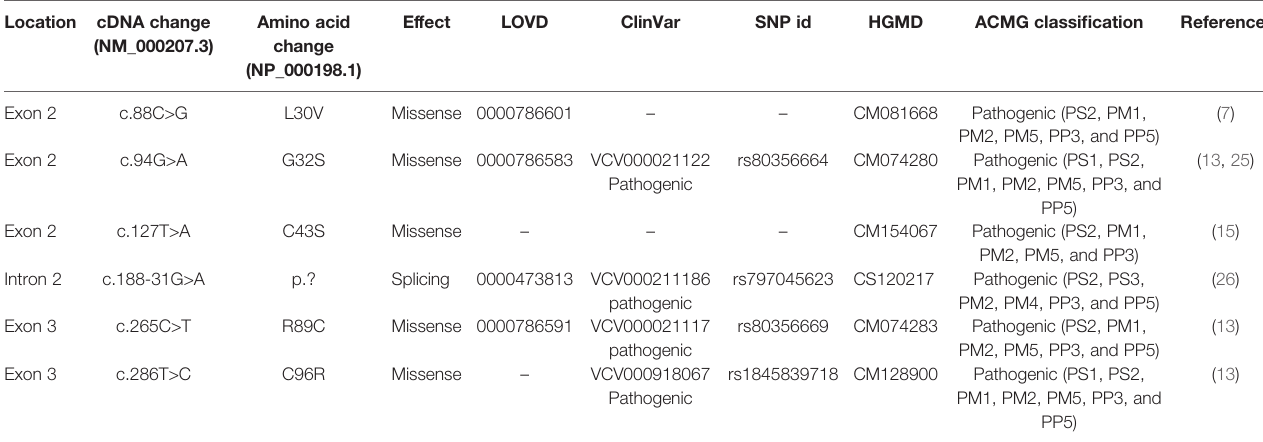
TABLE 3 | INS mutations identi fi ed in Vietnamese patients with neonatal diabetes mellitus. Location cDNA change (NM_000207.3)